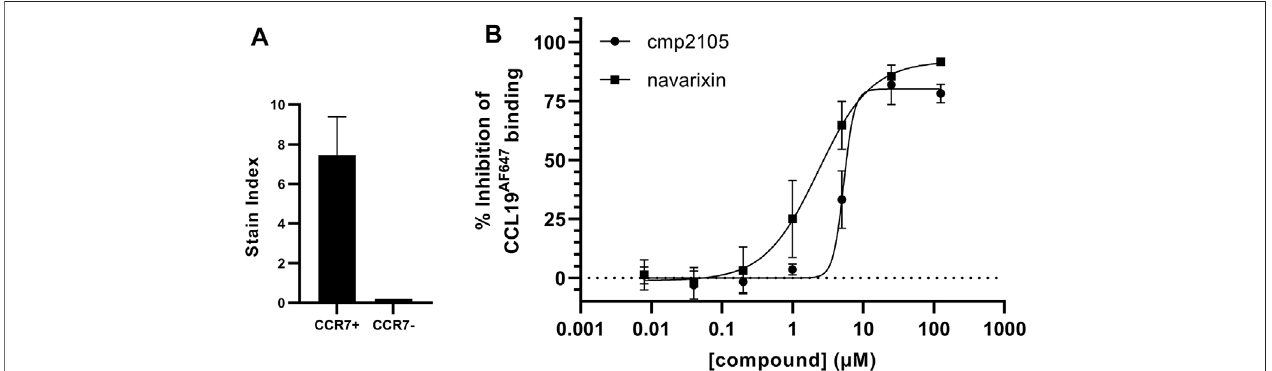
FIGURE2| Inhibition ofCCL19 AF647 binding by cmp2105 and navarixin(A) Incubation ofU87cells thatoverexpress CCR7 (CCR7+) withCCL19 AF647 generates a strong fl uorescent binding signal, which is not present when CCL19 AF647 is incubated with cells that do not overexpress CCR7 (CCR7-) (Mean stain index ±SD of two (CCR7-) or four (CCR7+) independent experiments) (B) Dose dependent inhibition of CCL19 AF647 binding by cmp2105 and navarixin .